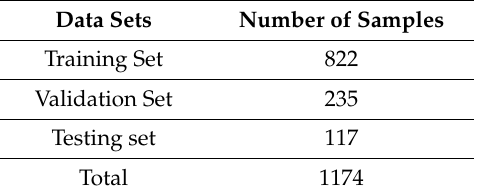
Table 2. Diversified SAR Ship Detection Dataset (DSSDD) dataset distribution.